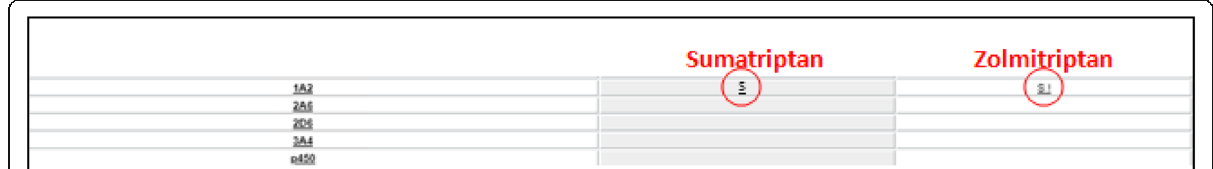
Fig. 4 Sumatriptan and Zolmitriptan metabolic profile. From left to right, in the first column there is the list of drug metabolizing enzymes, one for each row; in the second and third columns relationship between corresponding enzyme of the row and Sumatriptan (second column) and Zolmitriptan (third column): is indicated by the symbol ‘ S ’ for substrate. Enzyme CYP1A2 is rimmed to emphasize their importance in these triptans ’ metabolic destiny. Related page at the website http://bioinformatics.charite.de/transformer